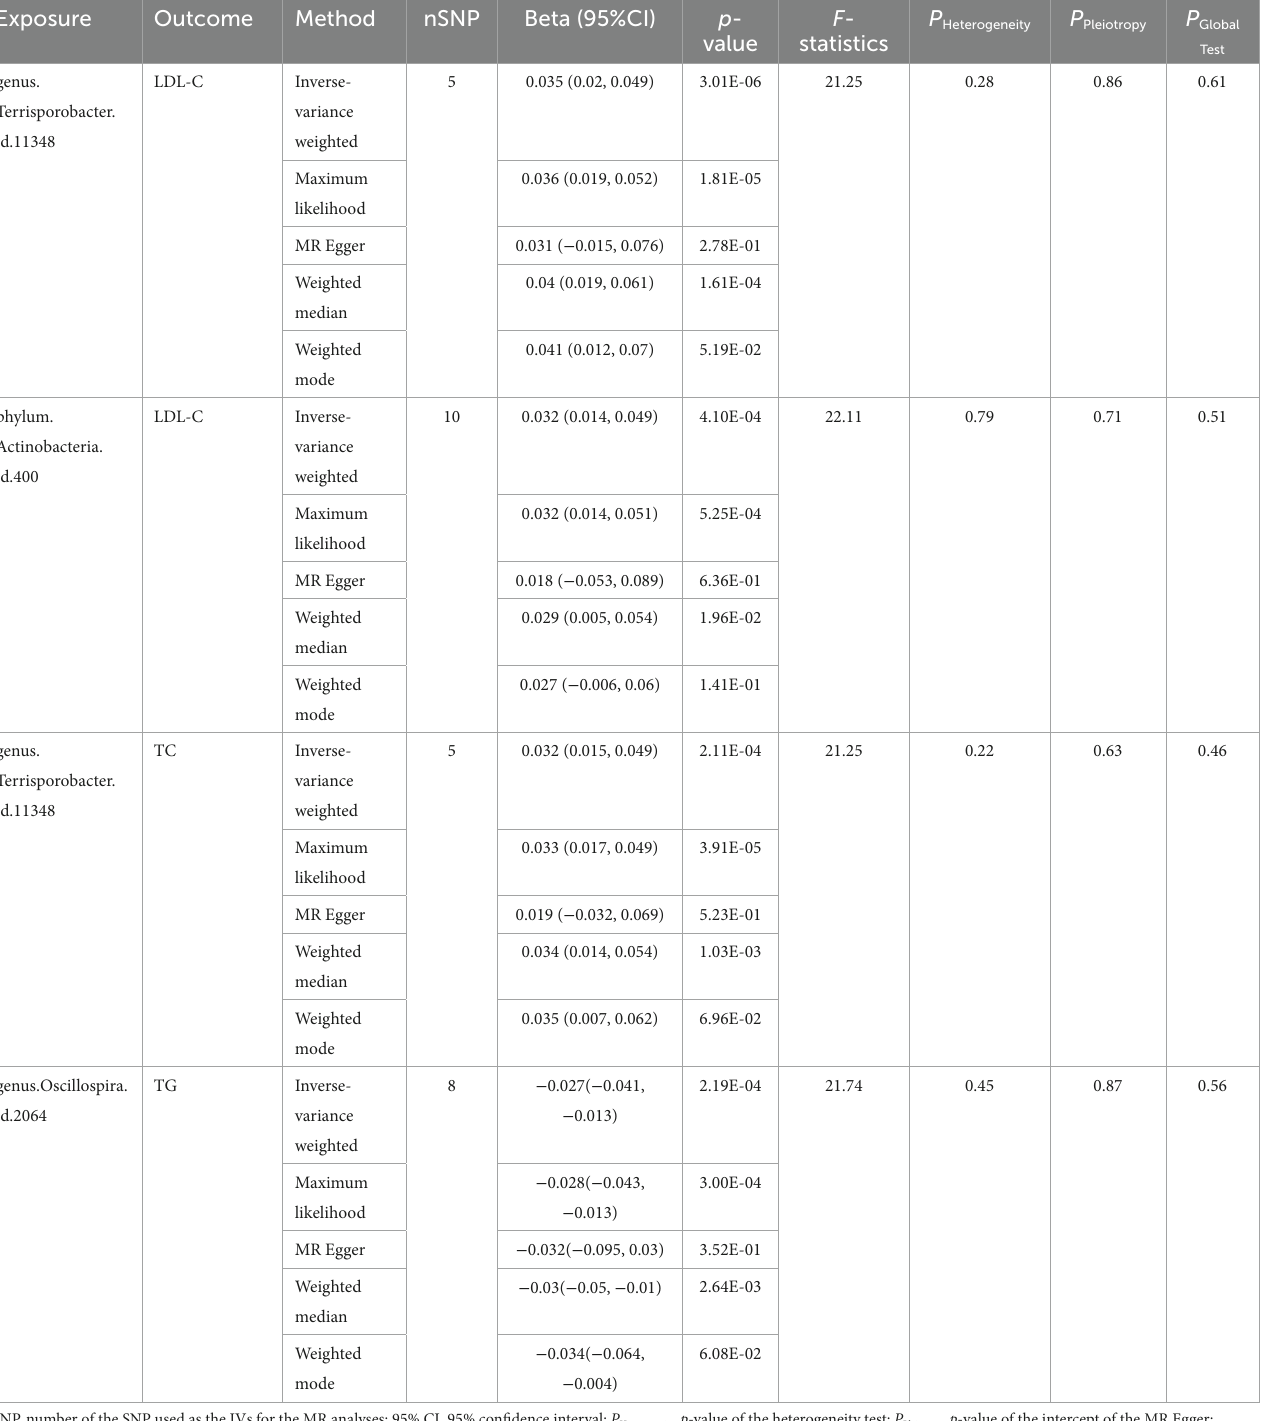
TABLE 2 Five MR models’ estimation of the causal relationships between identified bacterial taxa and serum lipid levels and tests for heterogeneity and horizontal pleiotropy.